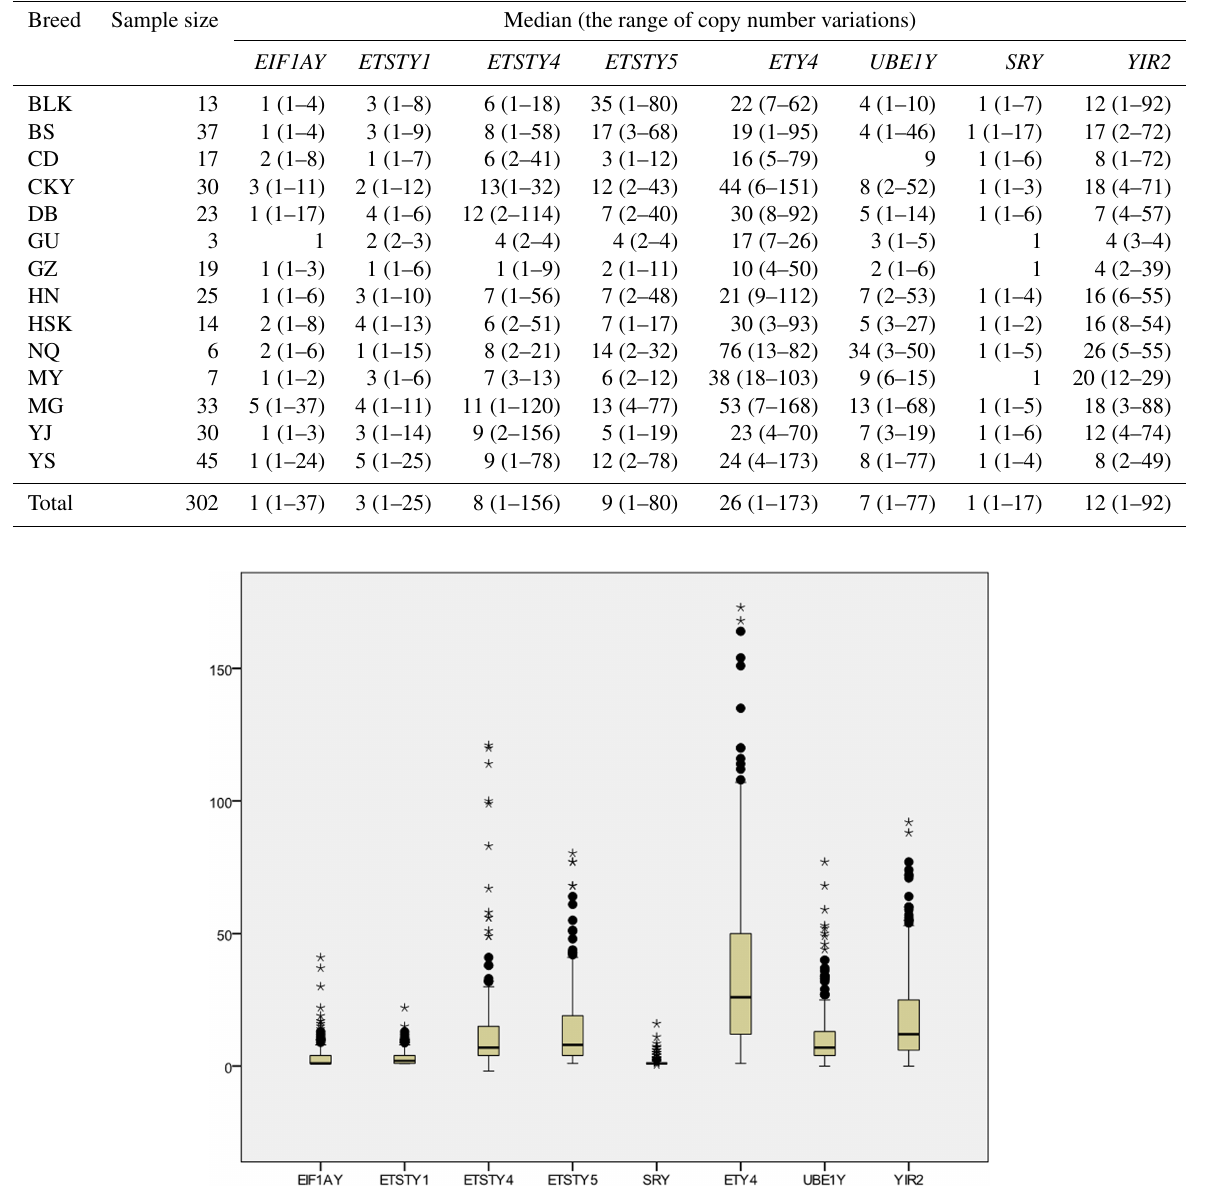
Figure 2. Box plot analysis of eight genes CNs in horse. The outliers were indicated by a solid circle or an asterisk (extremely high